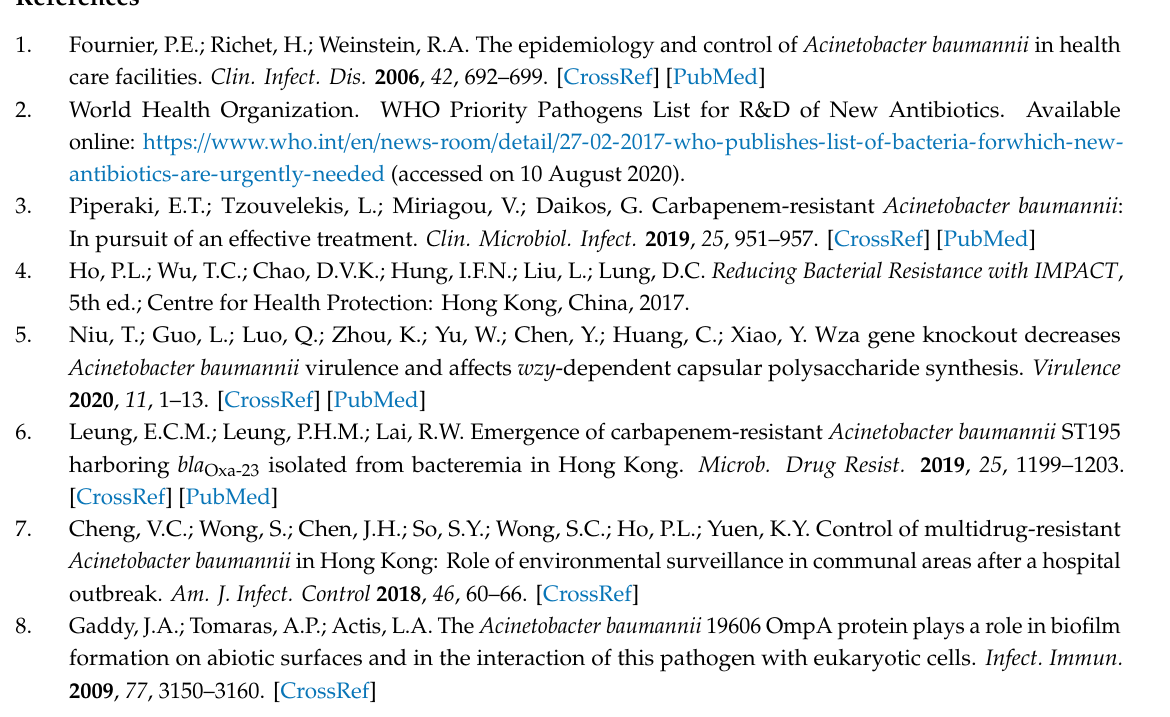
Figure S1: Biofilm-producing abilities and antibiotic susceptibility profiles of A. baumannii strains with di ff erent MLSTs, Table S1: Primers used for amplification of biofilm-associated